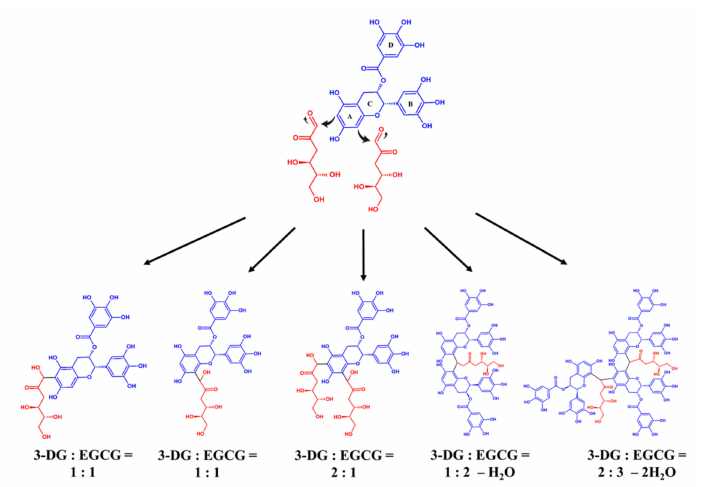
Figure 5. Possible formation pathway of adducts from the reaction of 3-DG and EGCG (EGCG: blue; 3-DG: